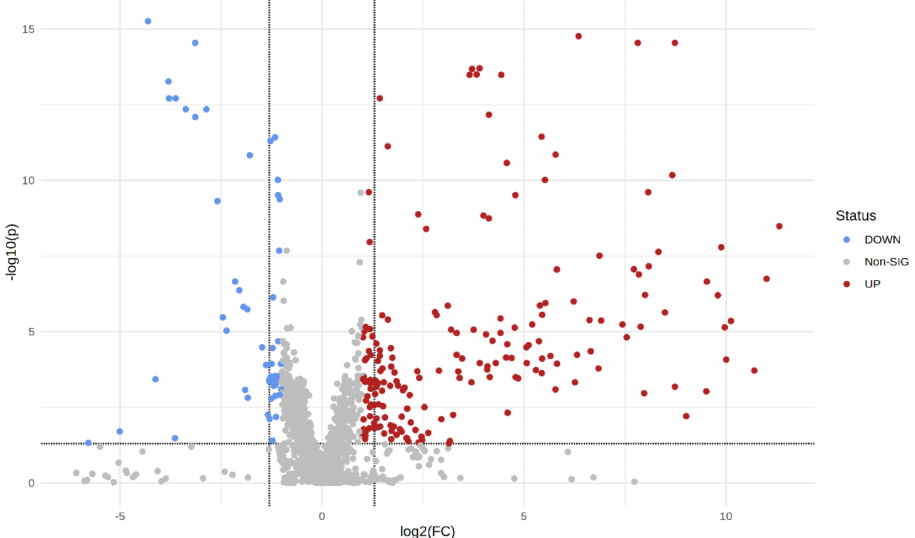
Figure 2. Important features selected by volcano plot with false discovery rate (FDR) < 0.05 and |FC| > 2 from univariate analysis. Red-colored dots denote up-regulated, blue-colored dots denote down-regulated, and grey-colored dots denote metabolites with non-significant